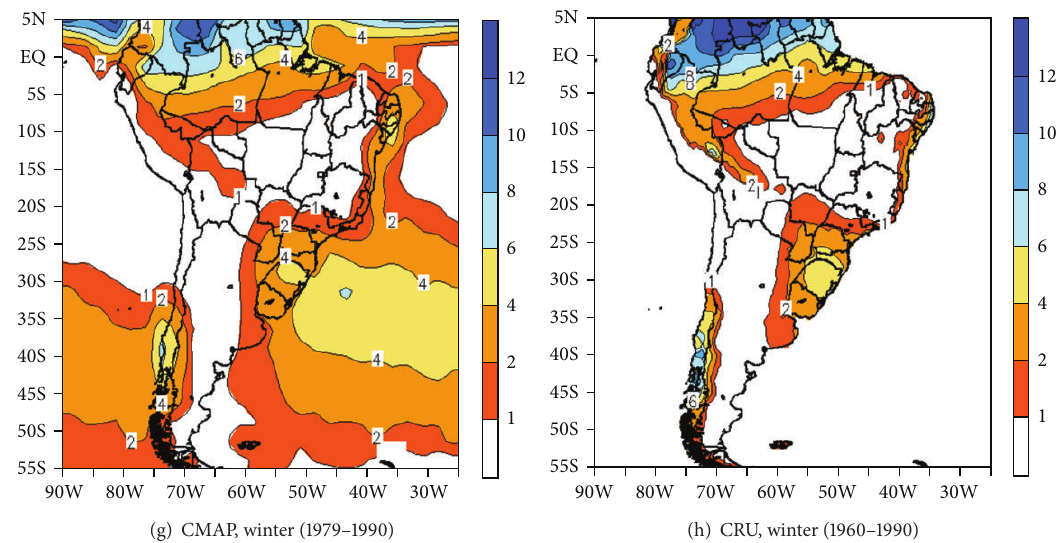
Figure 4: Mean precipitation (mm day −1 ) in ((a)–(d)) summer and ((e)–(h)) winter for the present (1960–1990) climate from RegHad, RegECHAM, CMAP, and